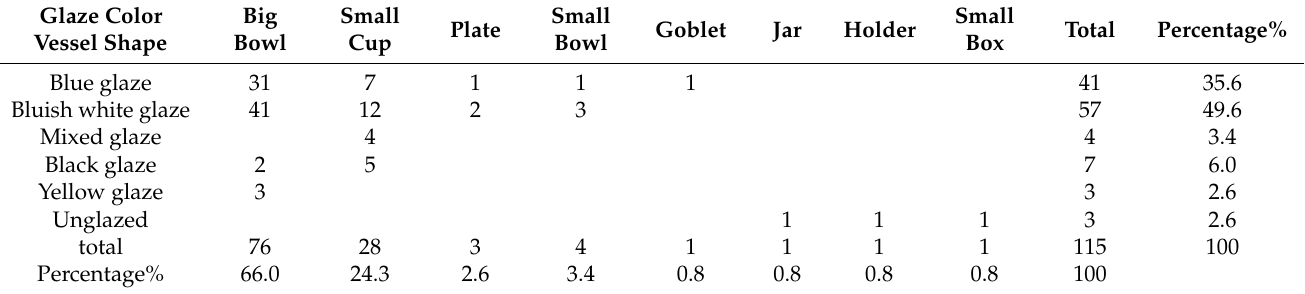
Table 1. Summary types and glaze colors of ancient ceramics used in Xiaopi kilns.